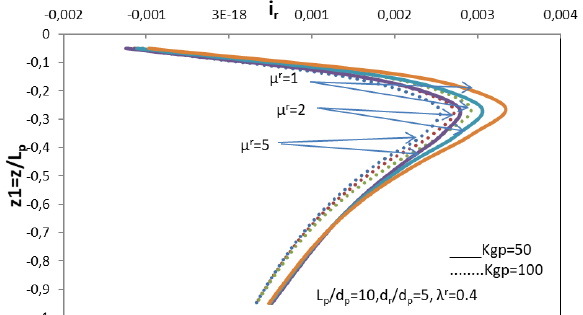
=z/ 1 Figure 12: Variation of normalized shear stresses, τ*= τ/(F/πd / with radial compatibility of the normalized depth, z p of stiffness factor, μ r , and comparative strengthening, K